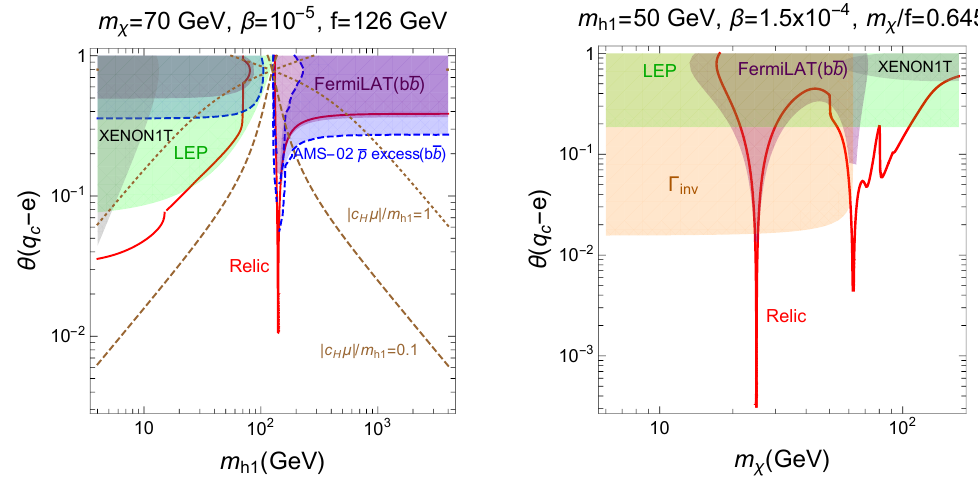
Figure 4 . Parameter space for the Higgs mixing angle, θ ( q c − e ) , vs the singlet-like scalar mass m h on left (dark matter mass m χ on right). We took m χ = 70 GeV , β = 10 − 5 and f = 126 GeV 1 on left and m h = 50 GeV , β = 1 . 5 × 10 − 4 and m χ /f = 0 . 645 on right. We also drew the contours 1 for | c H µ | /m h = 1 , 0 . 1 in dotted and dashed brown lines on left. The color notations are the same 1 as in figure